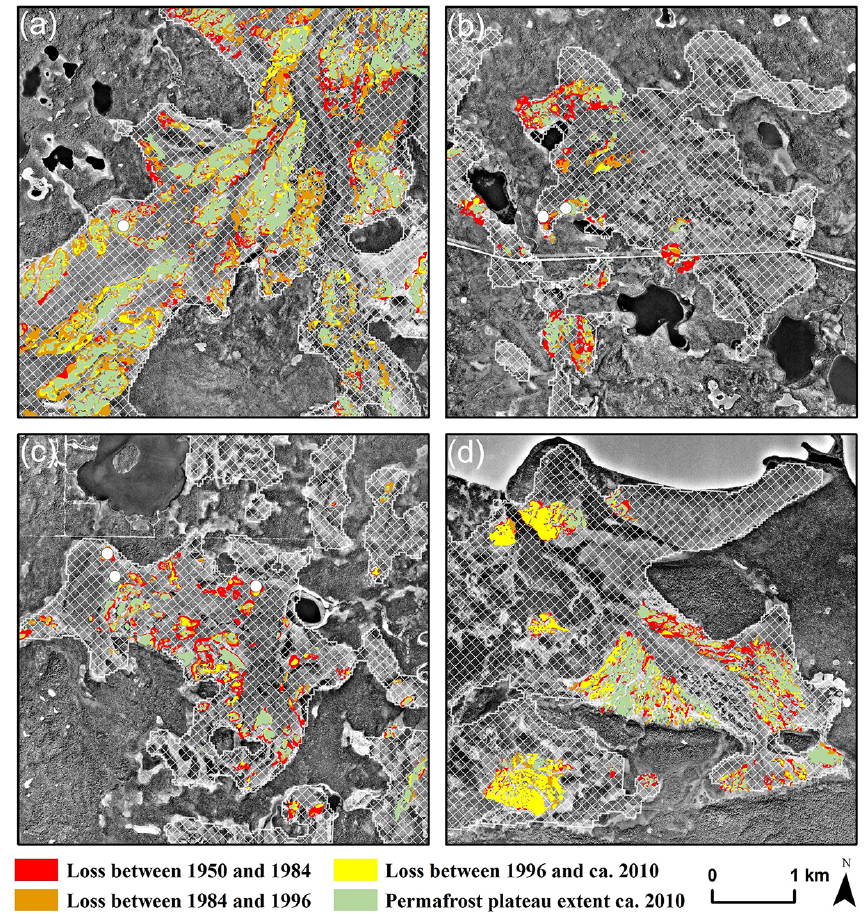
Figure 11. Spatial and temporal pattern of permafrost loss within four change detection areas: (a) Mystery Creek, (b) Watson Lake, (c) Browns Lake, and (d) Tustumena Lake. Red indicates feature loss between 1950 and 1980, orange is feature loss between 1984 and 1996, yellow is feature loss between 1996 and ca. 2010, and green is ca. 2010 permafrost plateau extent. The white dots indicate the location of field-verified permafrost between 2009 and 2016. The hatched white polygons indicate the wetland extent where plateau features were mapped in each study area. Background imagery is the 1996